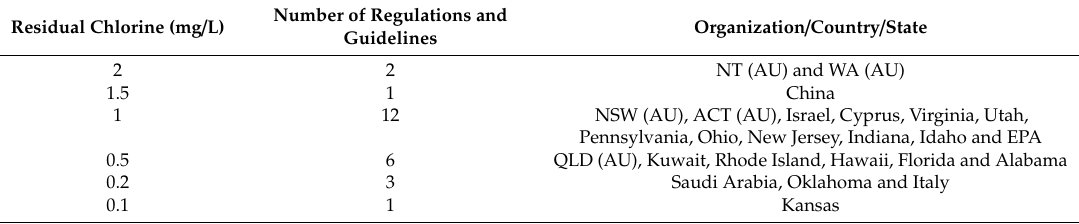
Table 14. Residual Chlorine thresholds in agricultural water reuse regulations and guidelines. Residual Chlorine (mg / L)